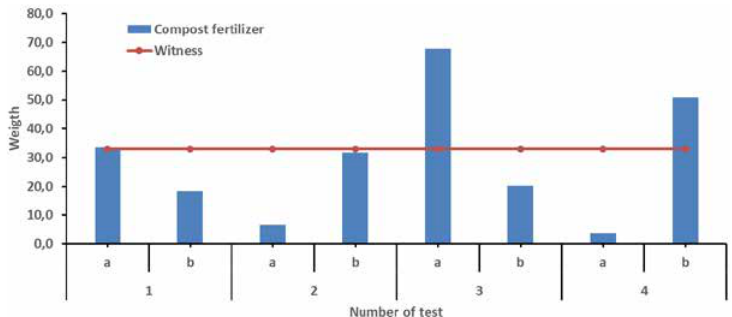
Fig. 6: Average weight (g) of the ears harvested in each treatment, a = dose of 100 g, b = dose of 200 g